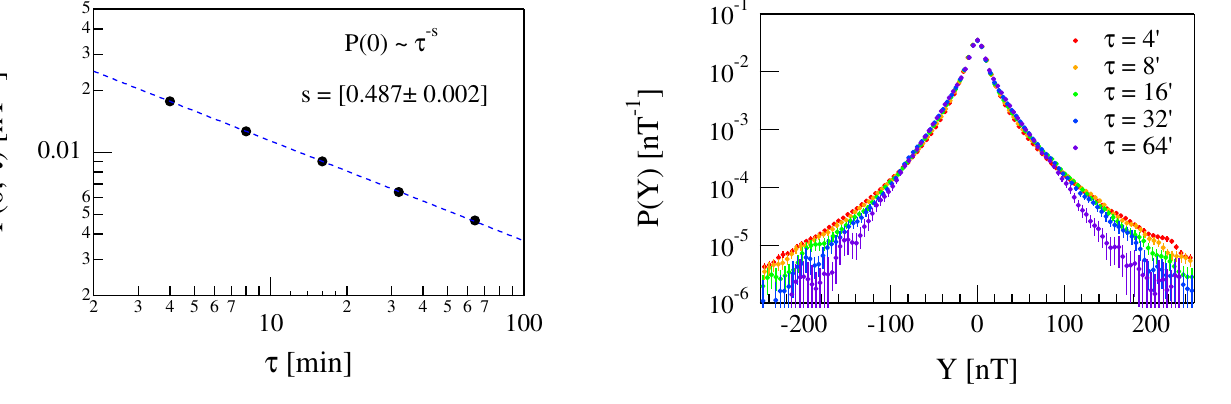
Fig. 2. The probability of return P( 0 ; τ) versus τ on a log-log plot. The dashed line is a power-law with exponent s ∼ 0 . 487. Fig. 3. Collapsing of the PDFs of the AE index increments δAE ( τ ) for τ = 4 , 8 ,..., 64 min, scaled according to Eq. (9). The scaling exponent is s = 0 . 487. Here P(Y) and Y stand for the scaled PDF and δAE , respectively.